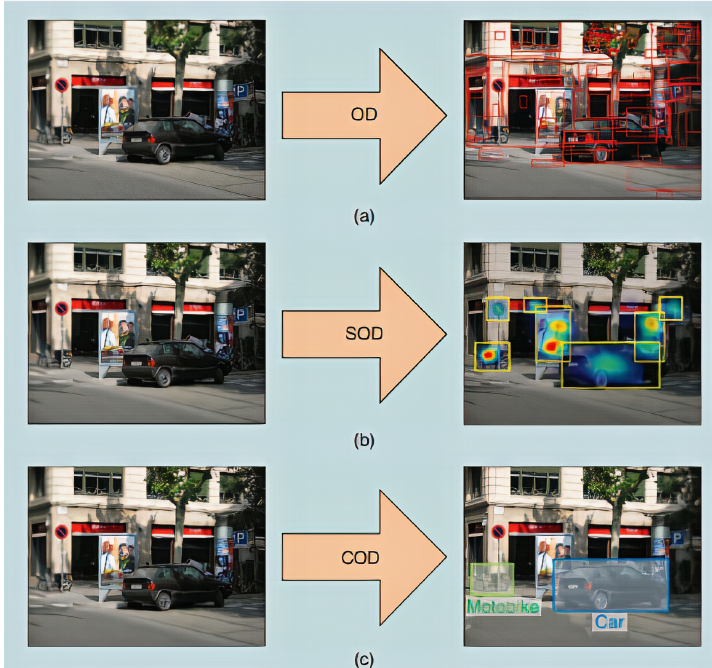
Figure 1. Visual demonstration of the possible three directions in the domain of object detection. Object detection (OD): objects are detected as illustrated in part ( a ), Salient Object Detection (SOD): human attention mechanism is applied to detect objects as presented in part ( b ), Category-specific object detection (COD): object detection along with the class prediction as depicted in part ( c ). Reprinted with permission from [30]. Copyright 2018